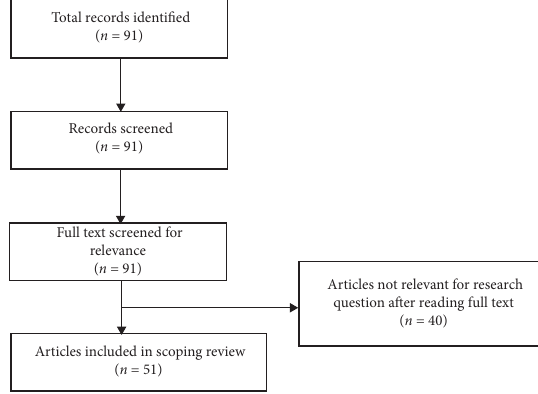
Figure 1: Flow chart of the studies’ selection